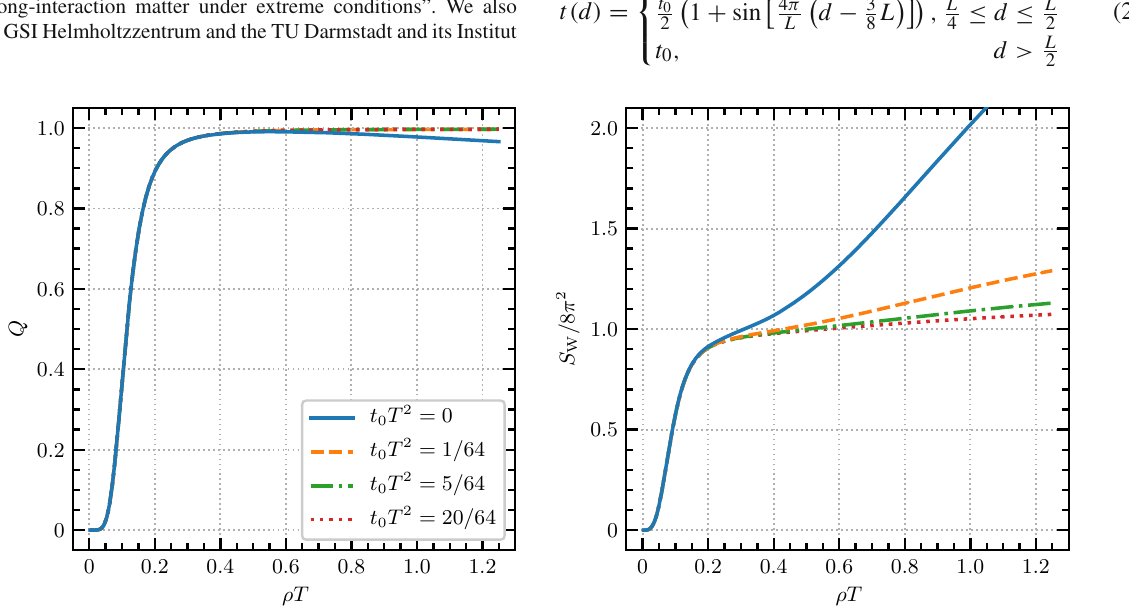
Fig. 8 Caloron topological charge (left) and Wilson action (right) for different values of t 0 T 2 as defined in Eq. (27) on an 8 × 48 3